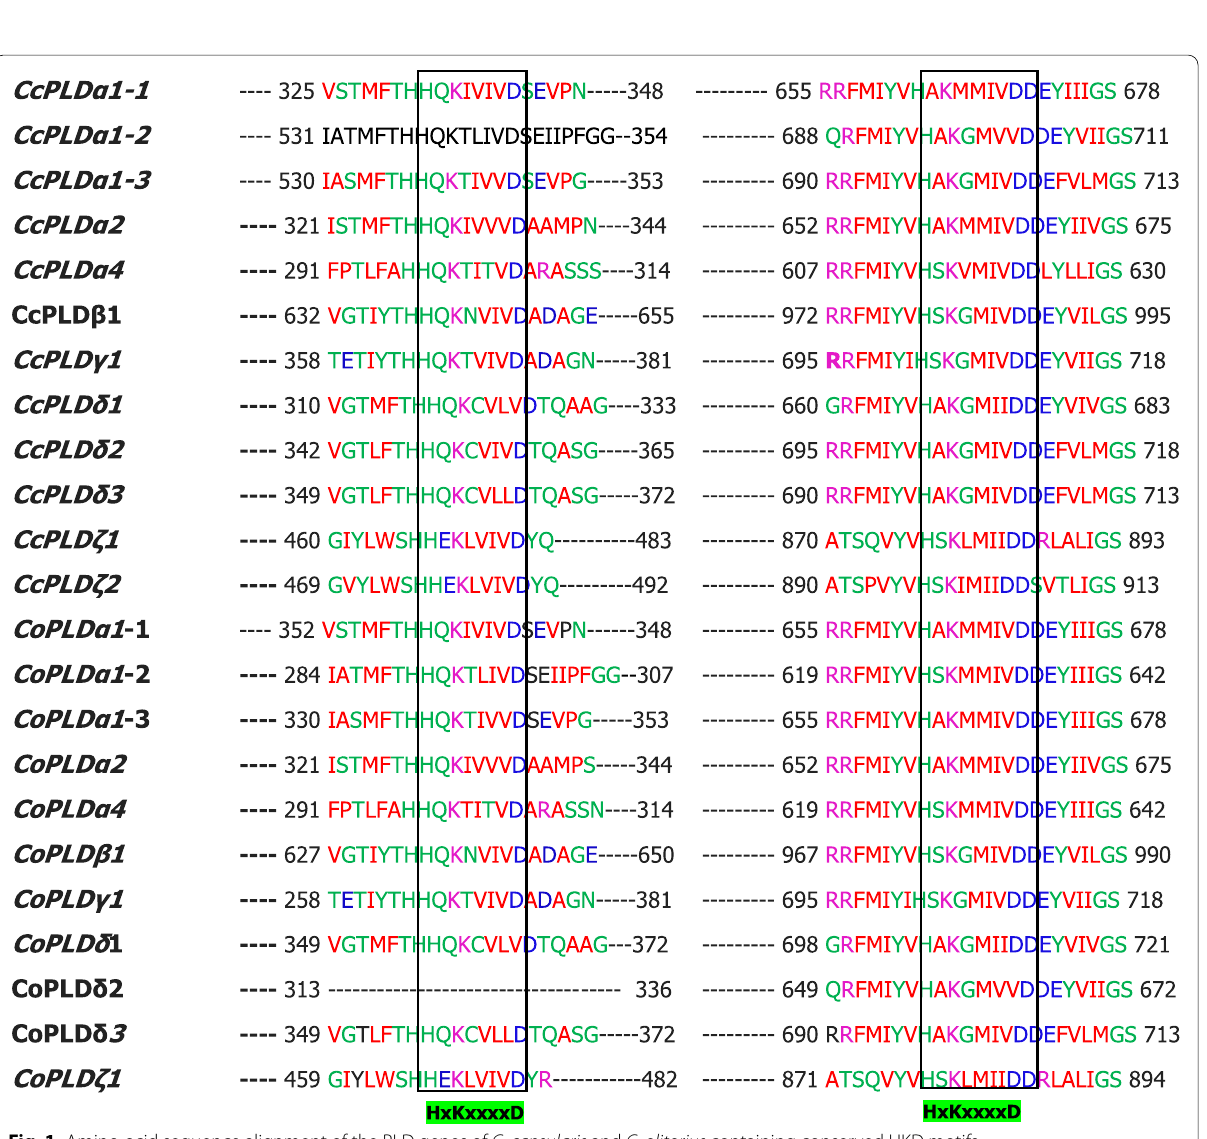
Fig. 1 Amino-acid sequence alignment of the PLD genes of C . capsularis and C . olitorius containing conserved HKD